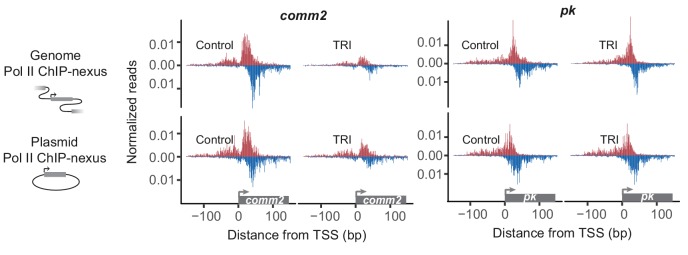
Reporter-ChIP-nexus recapitulates gene-specific Pol II pausing stability.The stability of paused Pol II was examined on the plasmids and at the endogenous loci by treatment with triptolide (TRI). After TRI treatment, paused Pol II is lost, and the degree of persistence relative to the DMSO-treated control condition is a measurement for the stability of paused Pol II. The examples of the comm2 and pk promoters show that the relative loss of Pol II on the plasmid is similar to that at the endogenous loci.